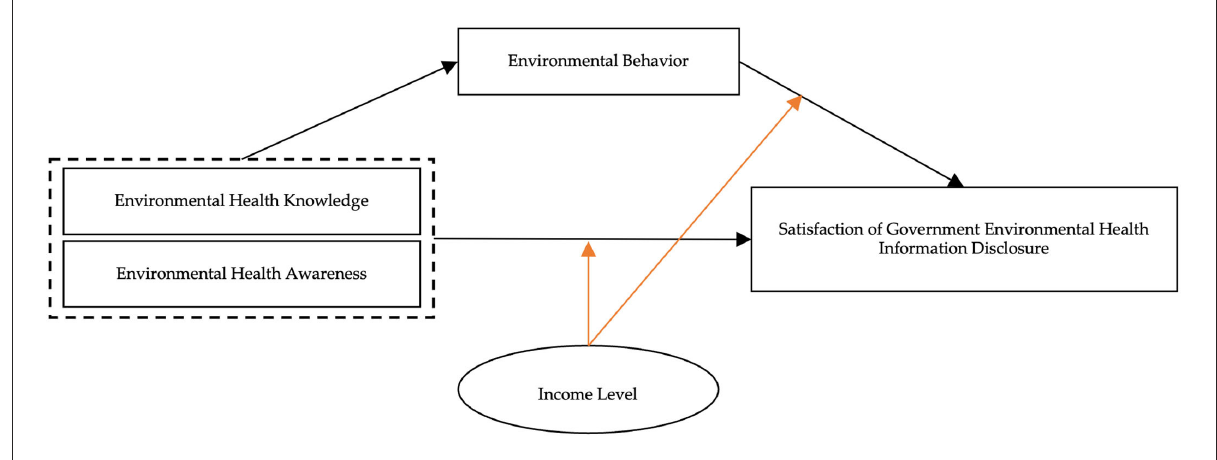
FIGURE1 Proposed concept